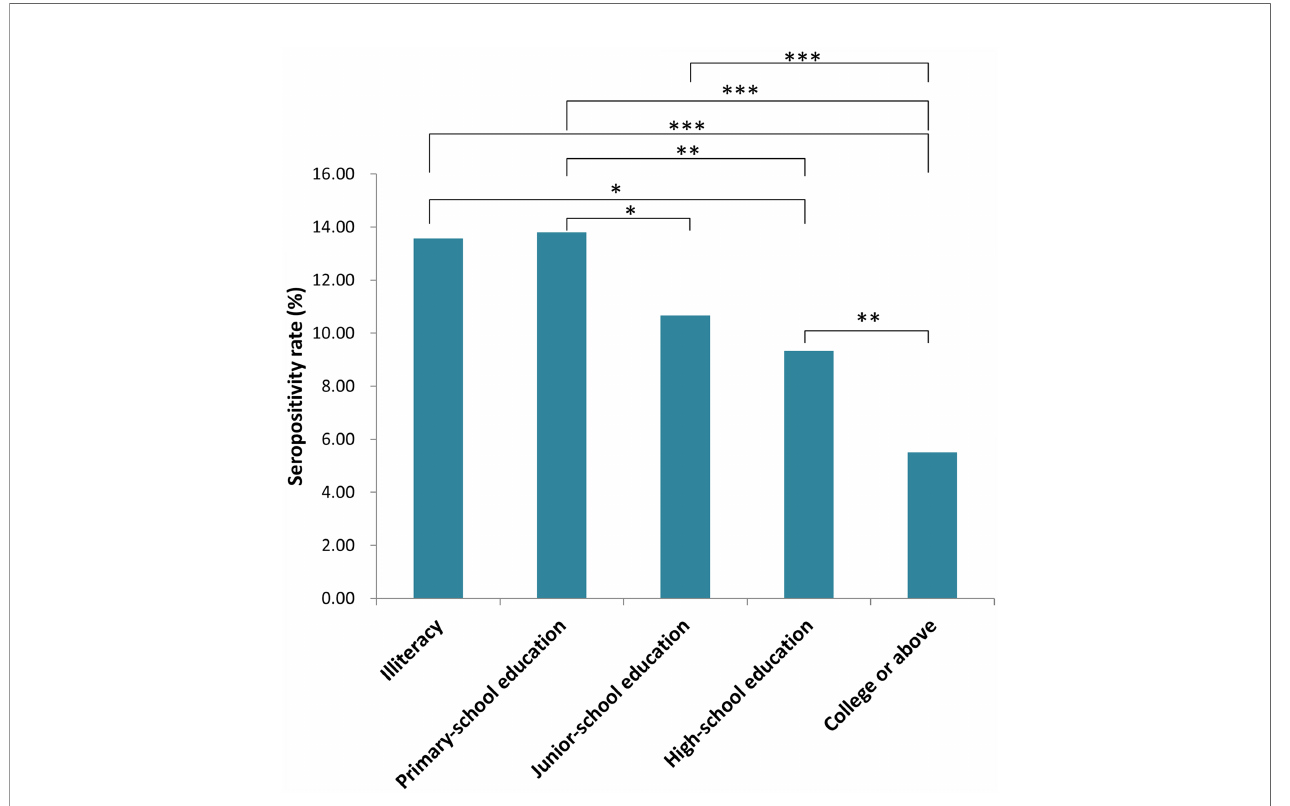
FIGURE 2 | Seropositivity rate for populations with different education level in Jiangsu Province, China. (* P < 0.05, ** P < 0.01, *** P <